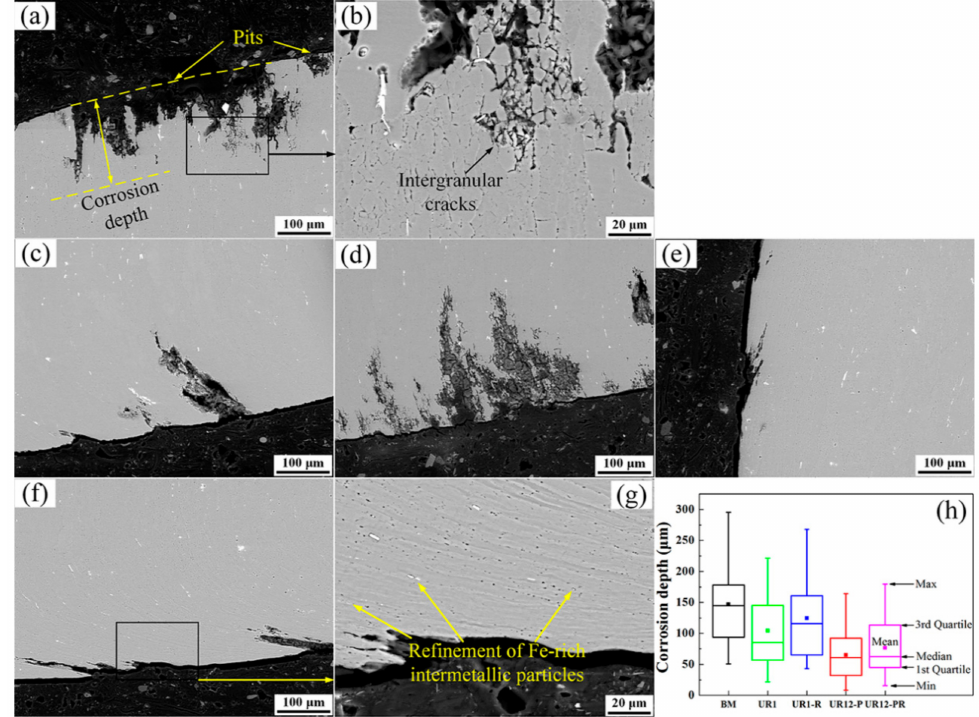
Figure 6. Typical cross-sectional SEM backscattered electron images of 7B50 aluminum alloy samples subjected to immersion tests: ( a , b ) untreated sample, ( c ) UR1, ( d ) UR1-R, ( e ) UR12-P, and ( f , g ) UR12-PR. ( h ) Corrosion depth statistics of these